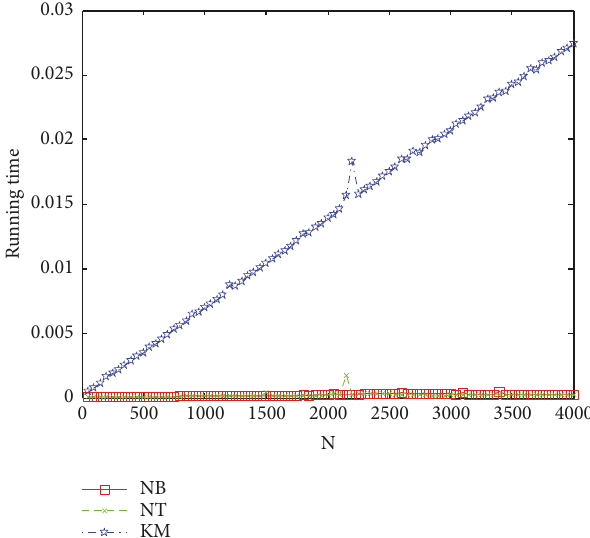
Figure 10: Computation time comparisons of example